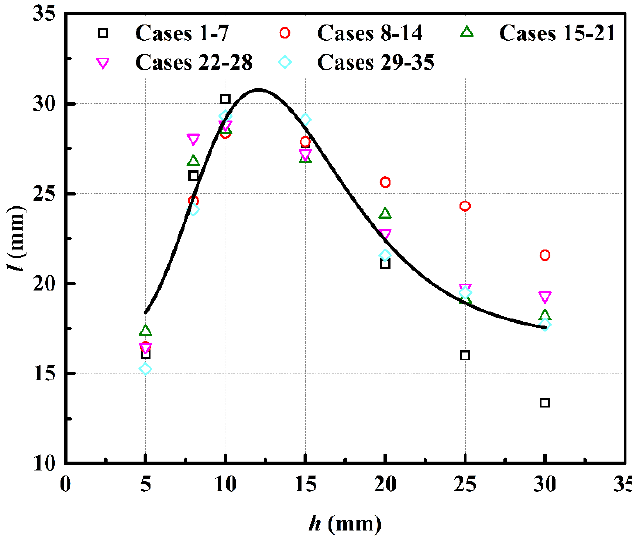
Figure 9. Variations of the border perimeter of the raised zone.